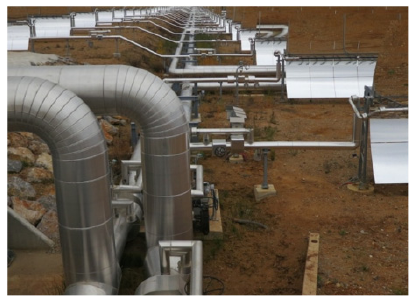
Figure 5. Headers. Figure 5. Headers.